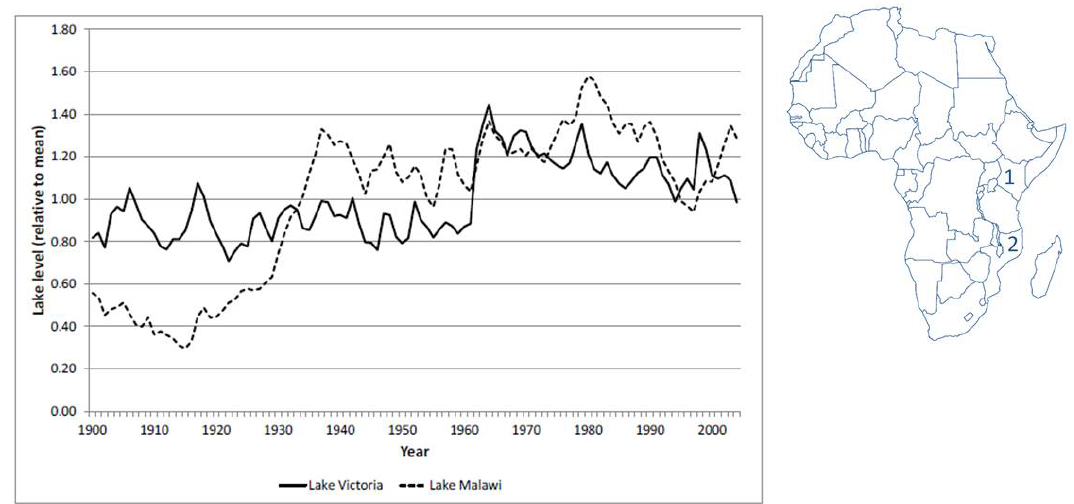
Figure 1. Annual lake level variations in Lake Victoria and Lake Malawi from 1900 to 2004 relative to the mean values in that period; values are expressed in terms of indicative depths at the lake outlet. The inset shows the locations of (1) Lake Victoria and (2) Lake Malawi.